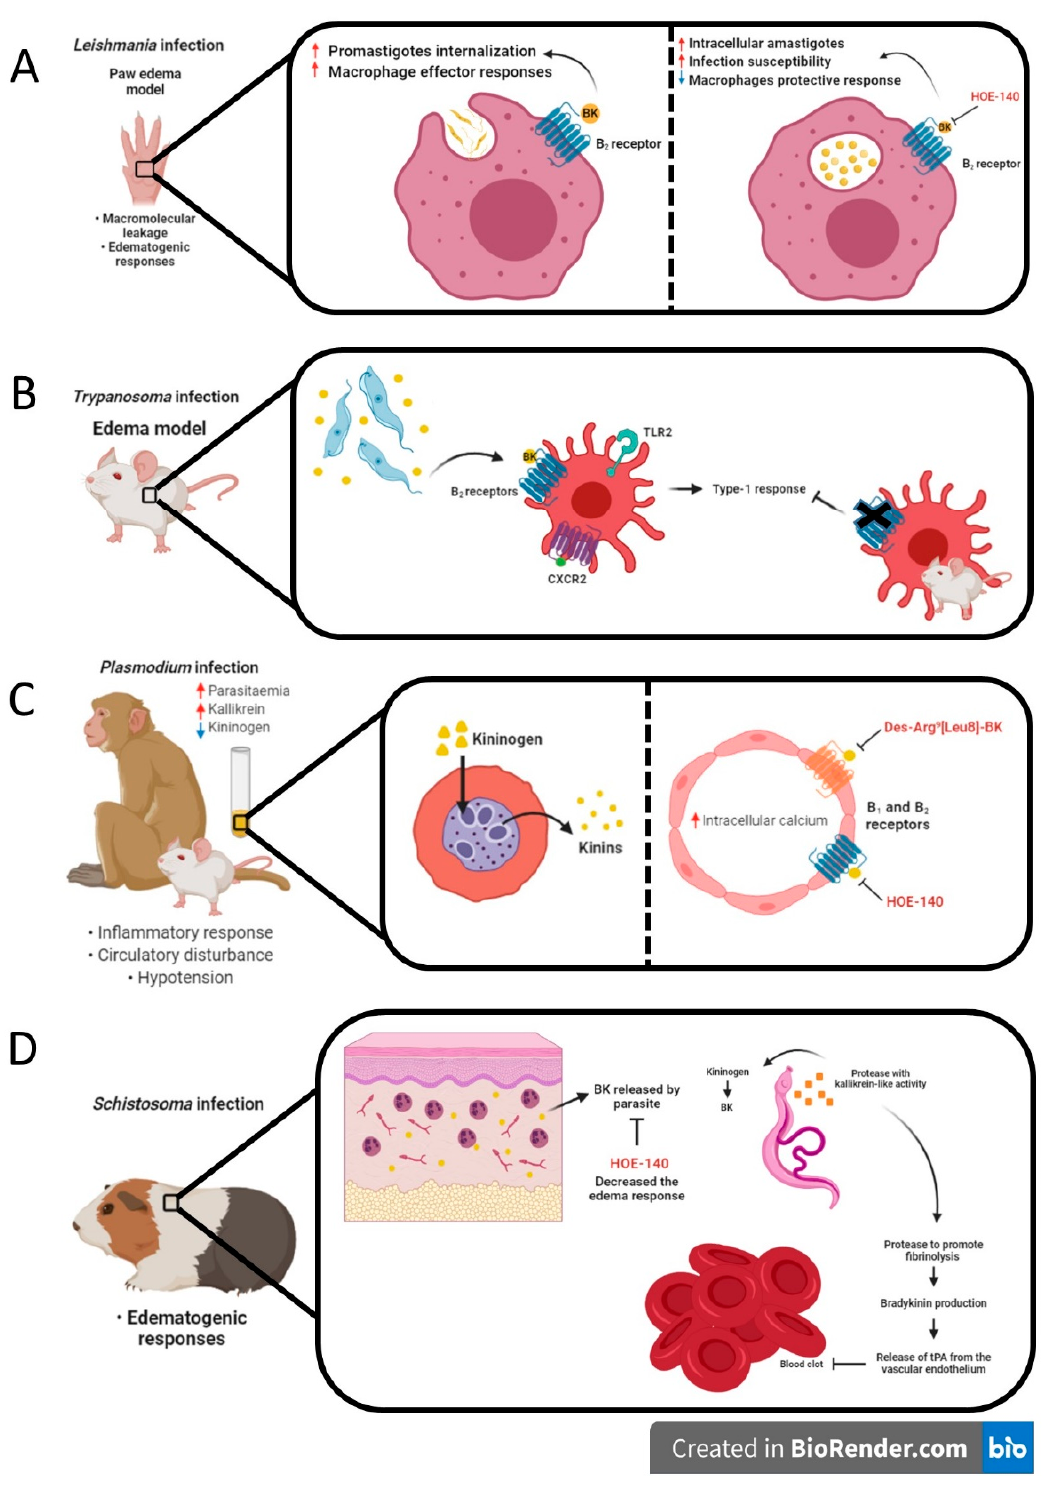
Figure 3. Animal models of parasite infection and the role of kinins. ( A ) Leishmania promastigotes induced macrophage effector responses through B 2 receptor activation by BK in the paw edema model. The treatment with BK increased the uptake of promastigotes by macrophages, whereas HOE-140 blocked this effect. Even with the reduction of parasite internalization, the treatment with HOE-140 caused an increase in the rate of growth of intracellular amastigotes, making host cells susceptible to infection. ( B ) Trypomastigotes release kinins and sensitize dendritic cells (DCs) via B 2 receptor activation. A cooperative activation of TLR2, CXCR2 and B2 receptors induces type 1 immunity. An impairment of type-1 responses was observed in CD11c+ DCs isolated from spleen of B 2 receptor knockout mice, that had been infected by trypomastigotes, with reduced IL-12 production. ( C ) Monkeys or mice infected by Plasmodium presented decreased HMWK and LMWK levels, while serum kallikrein concentrations and kinin formation were elevated. These results were accompanied by increased parasitemia and kininase activity. Parasites internalized plasmatic kininogen and liberated vasoactive kinins (Lys-BK, BK, and des-Arg 9 -BK) through the activation of cysteine proteases falcipain-2 and falcipain-3. B 1 and B 2 receptor activation triggered intracellular Ca 2+ increase in endothelial cells causing circulatory disturbances, while the selective kinin antagonists des- Arg 9 [Leu 8 ]-BK and HOE-140 restored this effect. ( D ) Intradermal injection of Schistosoma cercariae into the guinea pig skin induced edema formation, BK release and leukocyte accumulation, while HOE-140 decreased the edema response. Adult male worms cleave HMWK through protease activation. Proteases trigger BK production from kininogen, stimulating the release of tissue plasminogen activator (tPA) from vascular endothelial cells, which would promote fibrinolysis and anticoagulant effects. 5. Kinins and Fungal Infections Candida albicans is the most common opportunistic fungal pathogen in humans and is responsible for up to 50% of invasive candidiasis, albeit it is commensally present in skin and mucosal surfaces (i.e., oral cavity, genitourinary system, and gastrointestinal tract). Additionally, non- albicans species have been recognized as serious infection agents in humans, such as C. glabrata , C. parapsilosis , C. tropicalis , C. krusei , C. kefyr , C. lusitanie , and C. dubliniensis [186]. In general, immunocompetent individuals do not show Candida -related infections. In contrast, subjects with a compromised immunity can display annoying and painful infections, including oral thrush, cutaneous candidiasis, and/or vulvovaginitis. In severe cases, i.e., immunosuppressed patients (HIV, cancer therapy, organ transplantation, or diabetes), the development of systemic candidiasis can occur, being associated with high morbidity and mortality rates [187]. It is important to highlight that the conditions mentioned above are dependent on geographical location, population susceptibility, as well as the use of antifungal drugs. In this context, kinin production is enhanced in infection as a host defense against invading pathogens, including the recruitment of neutrophils or monocytes to the infection site, or promotion of the pro-inflammatory cytokine secretion through other immune cells. Yet, kinins can exert a dual